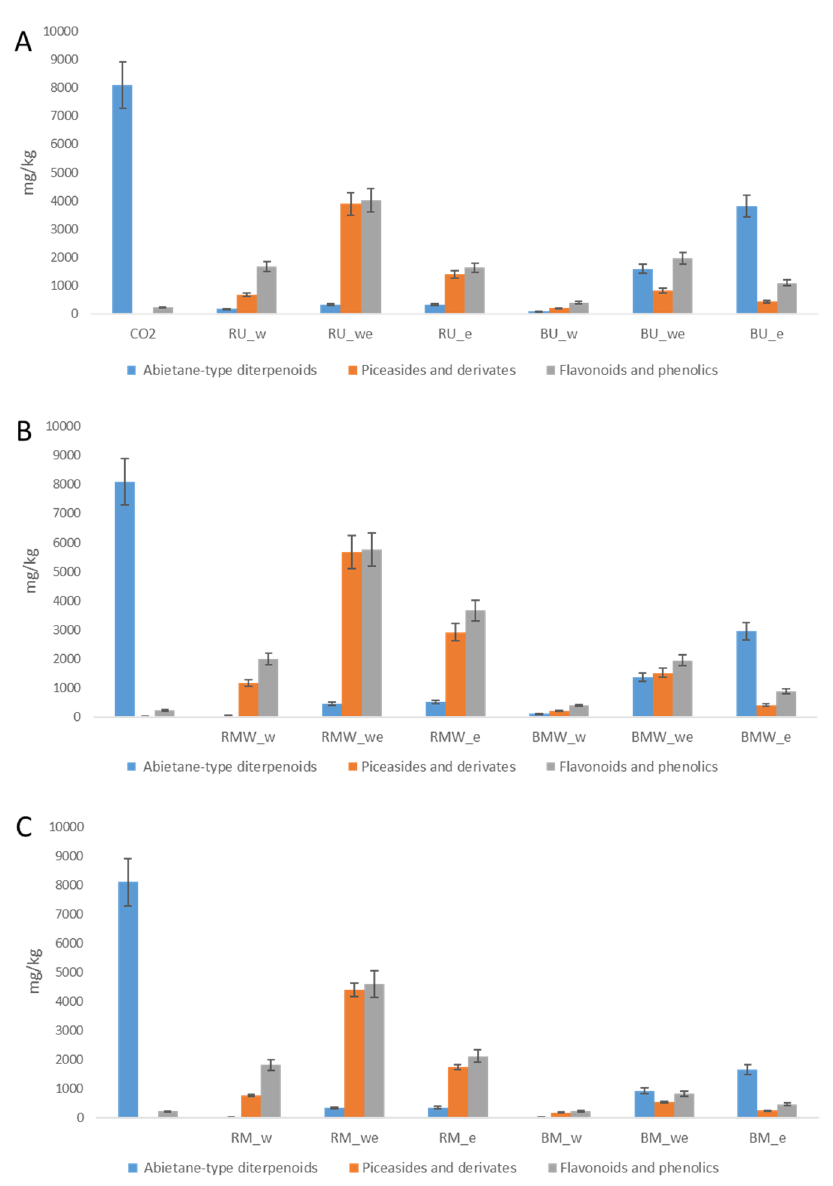
Figure 3. Amount of secondary compounds expressed as mg/Kg of bark obtained by UAE ( A ), MAE ( B ) and M ( C ). Values are reported in Table S1.